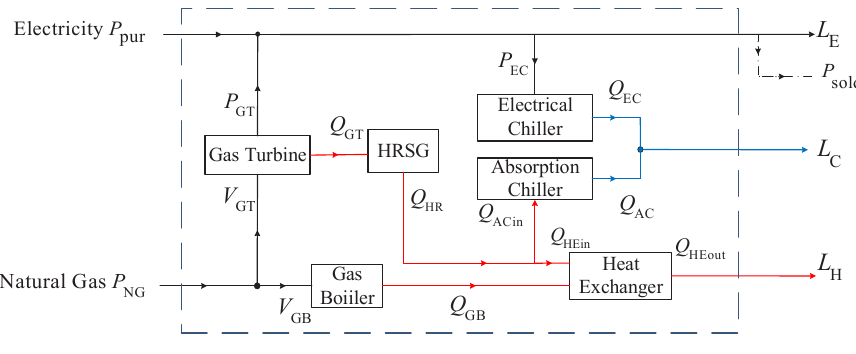
Figure 1. Schematic diagram of an energy